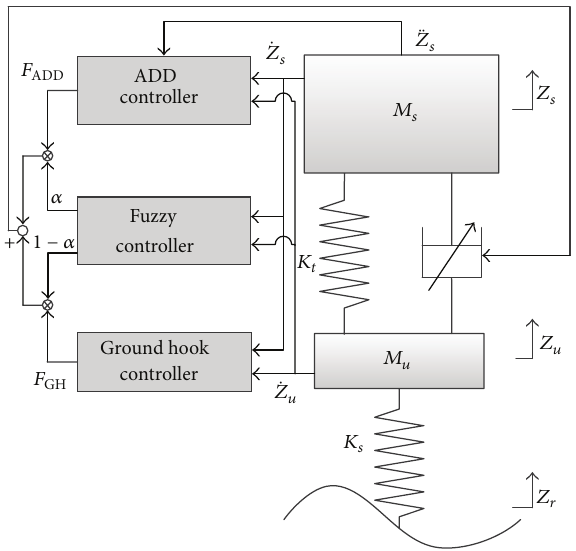
Figure 5: Quarter-vehicle SAS system model with hybrid-SH and GH-control.